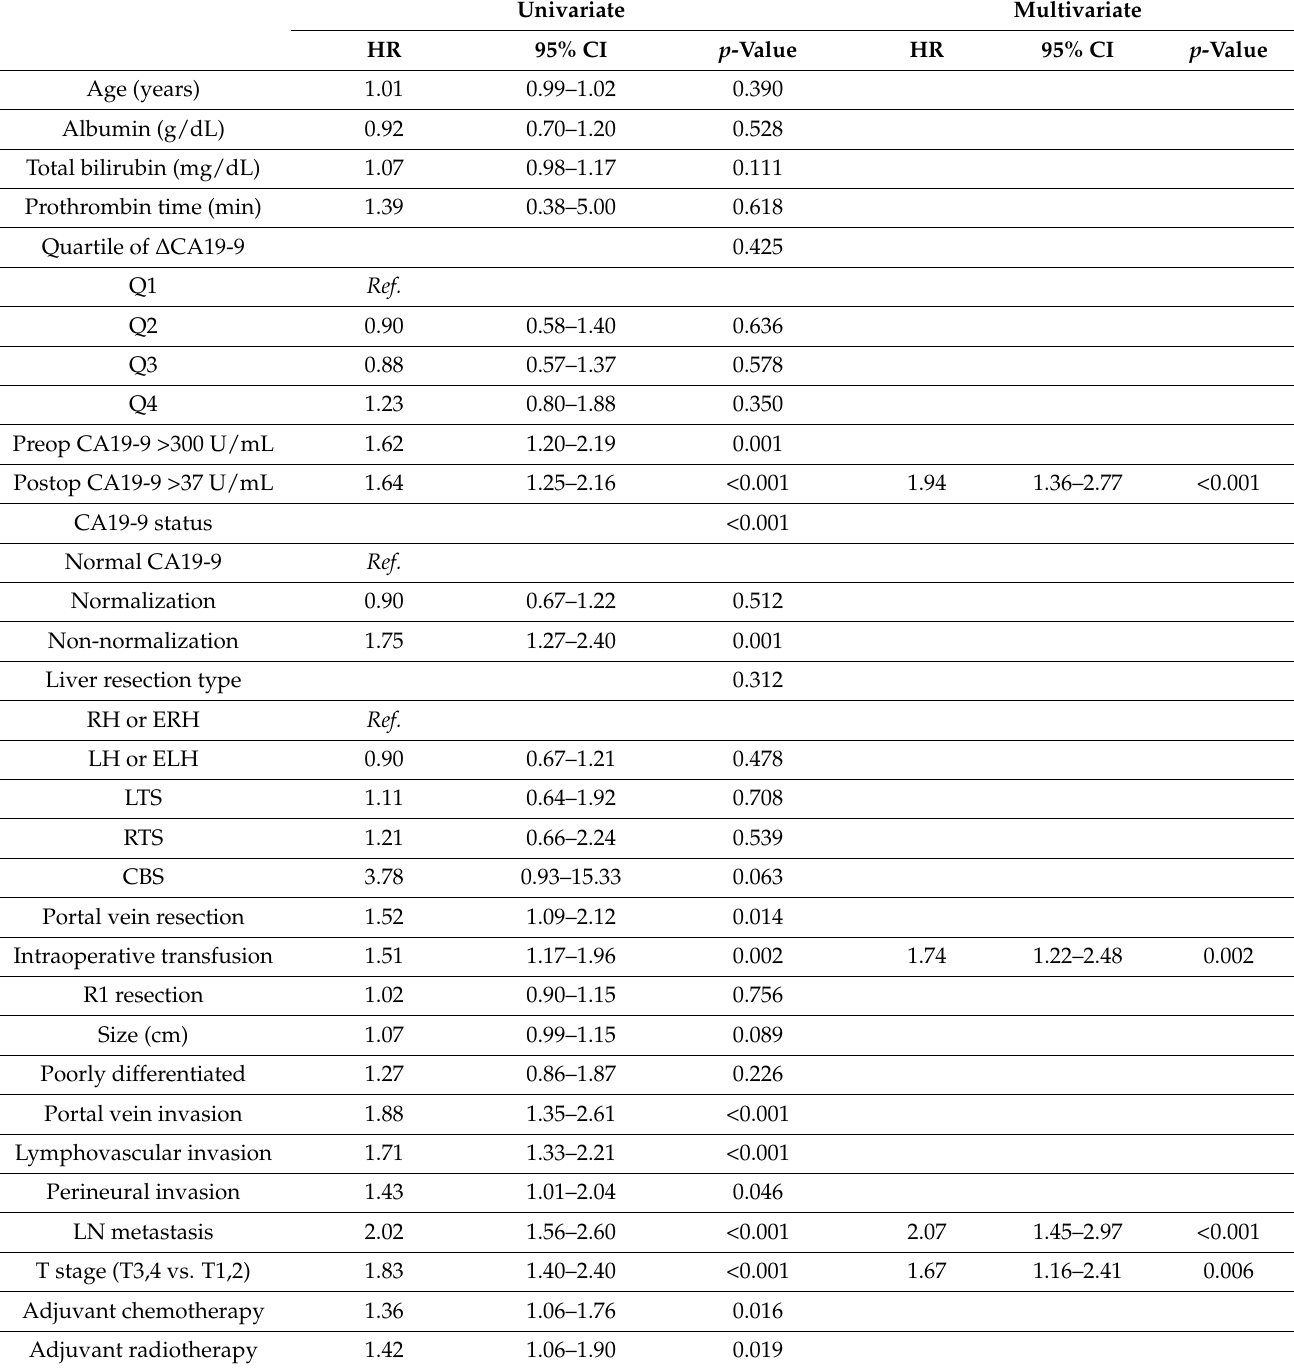
Table 3. Univariate and multivariate analyses of predictors of overall survival after surgery for 322 resected patients. Univariate